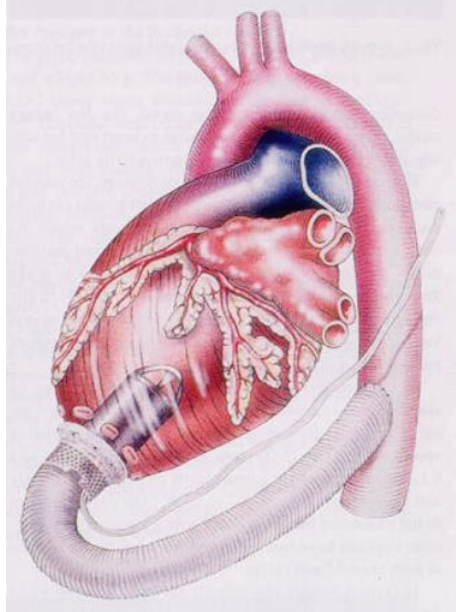
Figure 5 Jarvik 2000.